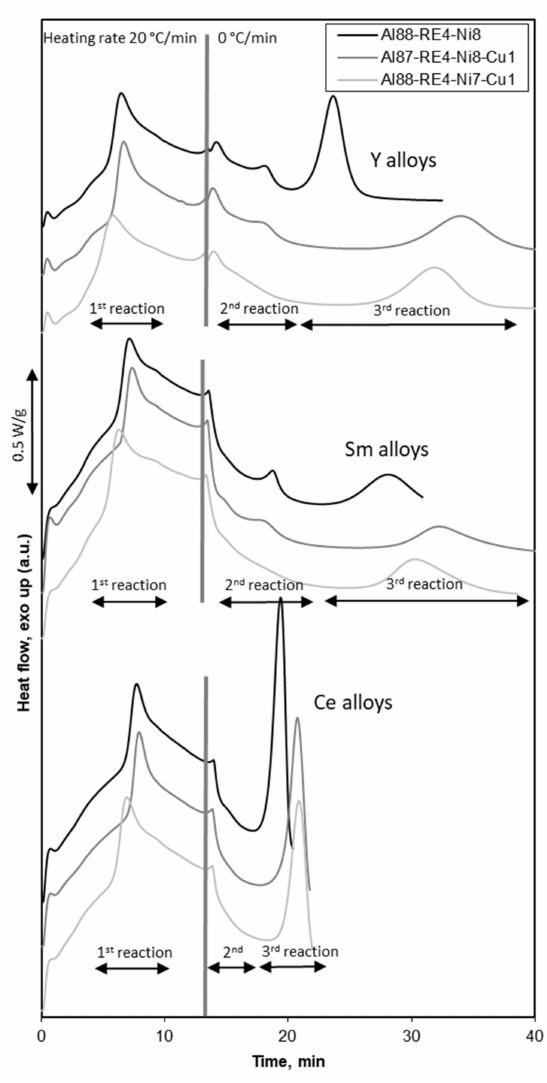
Figure 4. DSC traces (heating rate of 20 ◦ C / min up to 5 ◦ C before the onset of the second reaction and then maintaining the temperature) of the Al-RE-Ni-(Cu) alloys (vertical lines mark the heating regime